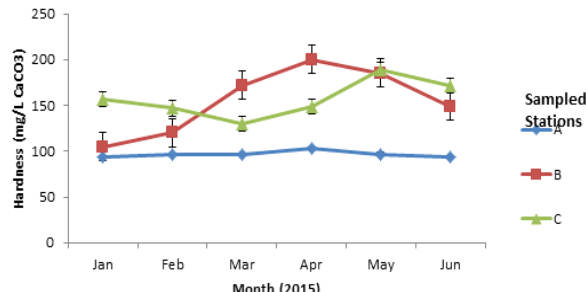
Fig. 5. The monthly mean variation in the total hardness (mg/L CaCO ) of the water sampled from Saba 3